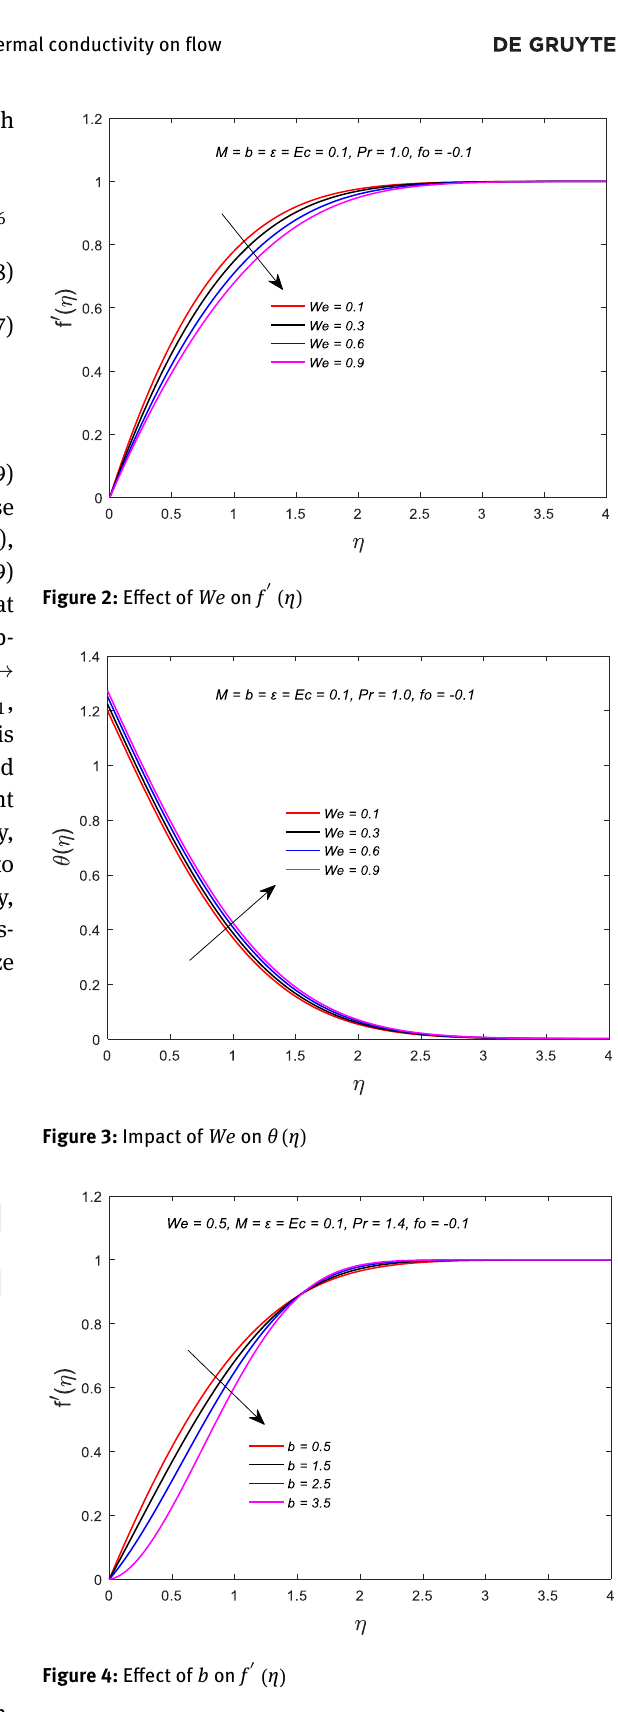
Figure 4: Effect of b on f (cid:48) ( η